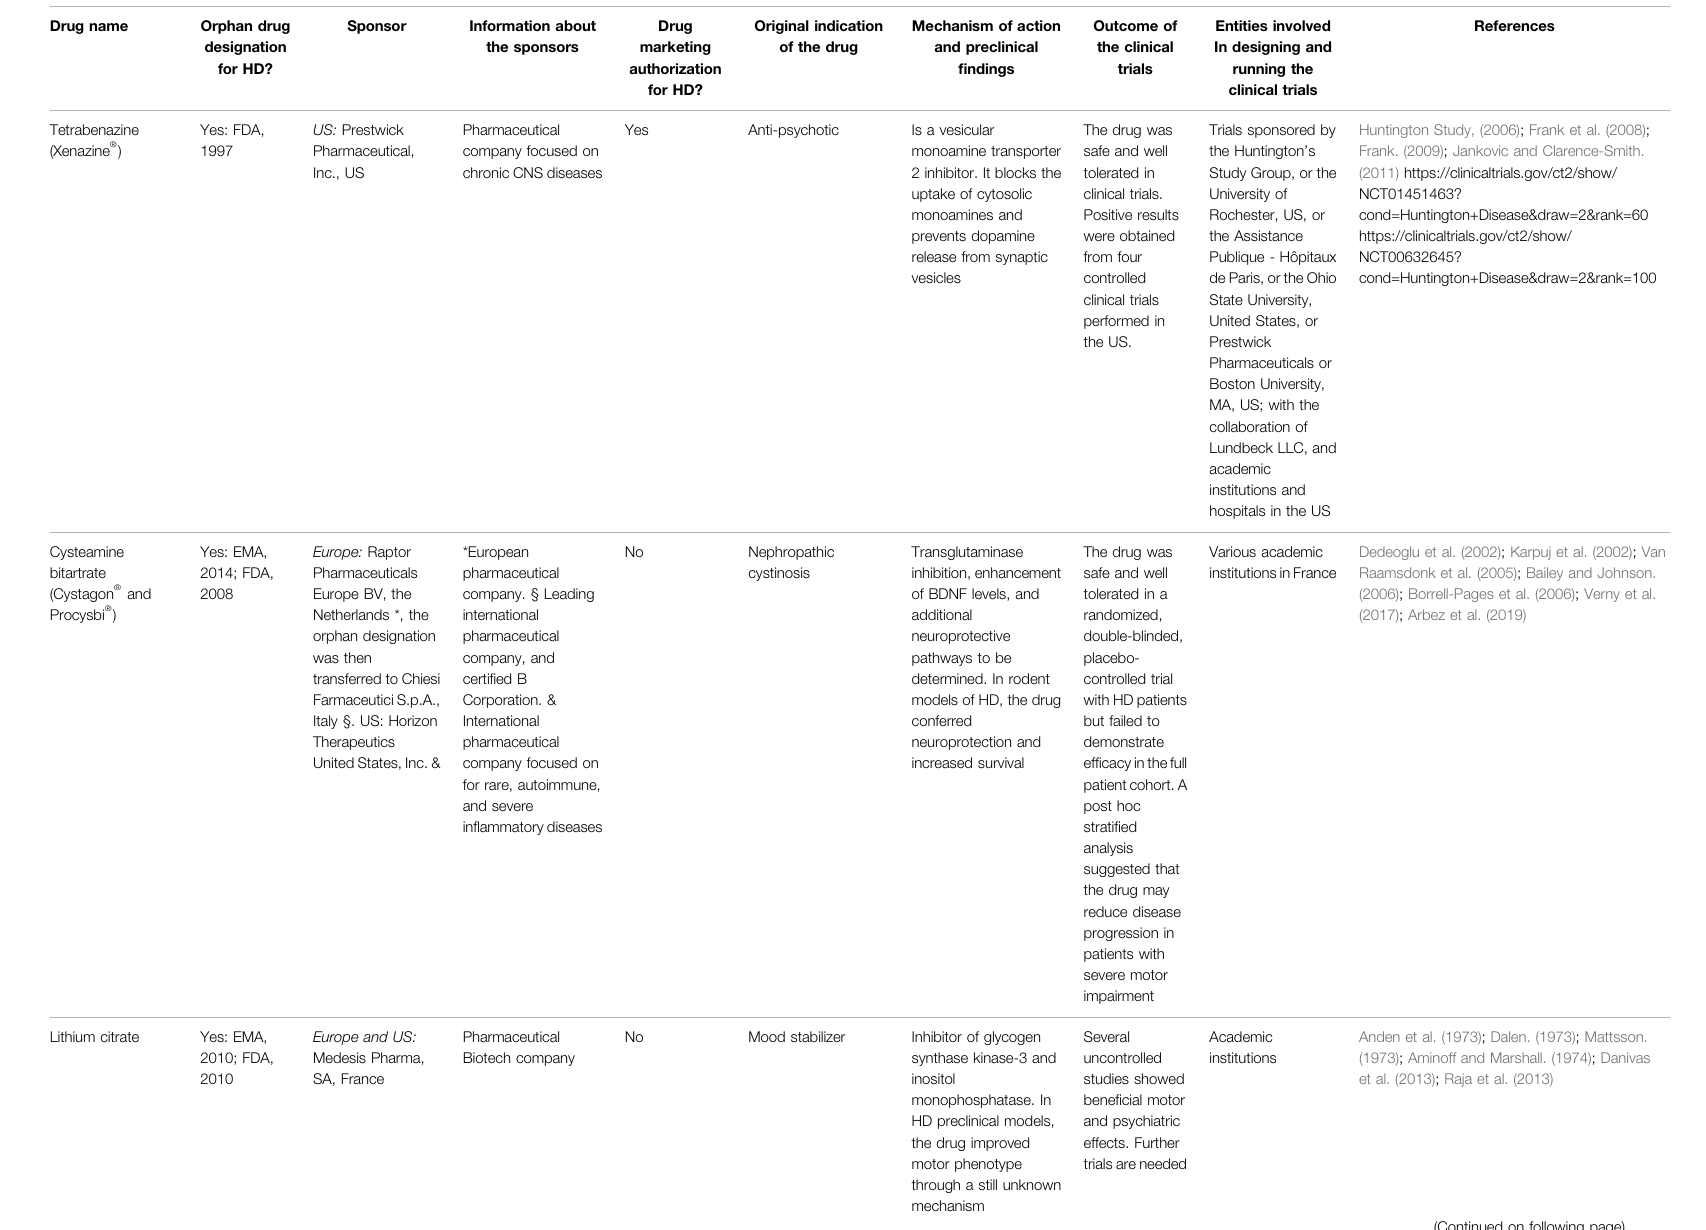
TABLE 1 | List of the repurposed drugs, with and without orphan designation or drug marketing authorization for Huntington ’ s disease (HD) mentioned in this article. The sponsors (entities involved in making the orphan designation request to the EMA or the FDA), and the public or private organizations involved in designing and running the clinical trials are detailed. N/A (cid:1) non-applicable. Drug